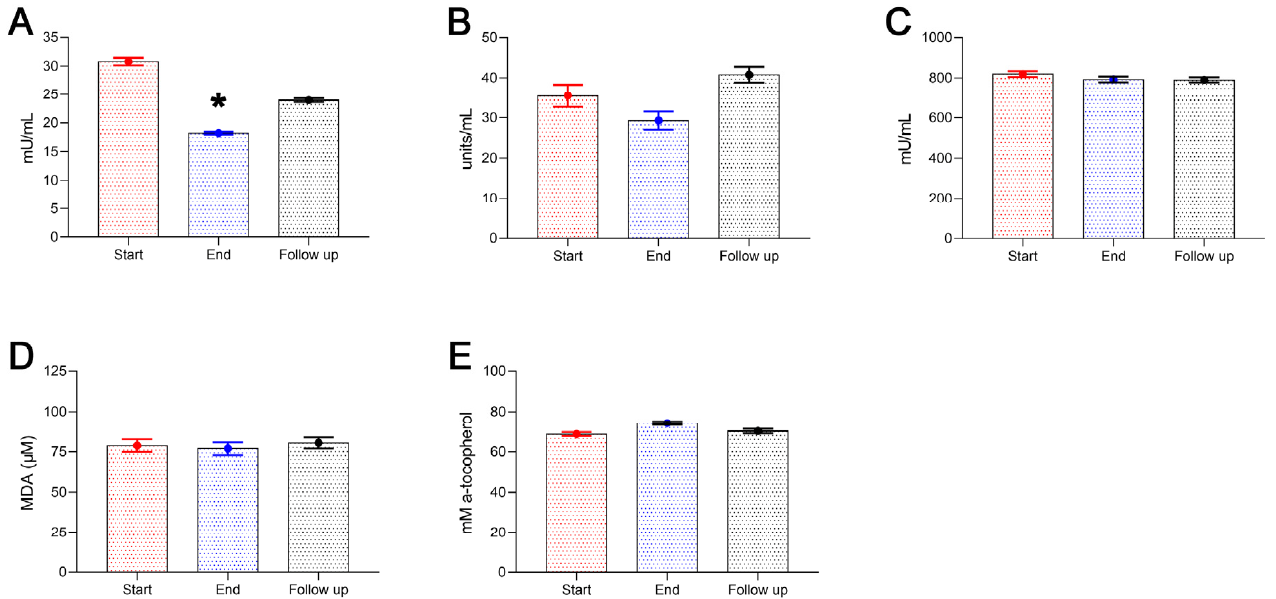
Figure 4. Antioxidant enzyme activity and markers of oxidative stress of the subjects during the study. Plasma levels of oxLDL significantly decreased following Antiox-Plus supplementation ( p < 0.05) ( A ). oxLDL increased at follow-up, however, it remained lower than the pro-supplementation period. The Antiox-Plus supplement also exerted a non-significant reduction in catalase activity ( B ). Likewise, glutathione was unaffected by the supplement ( C ). The total antioxidant capacity of plasma was slightly increased ( D ), and lipid peroxidation levels remained stable ( E ). Statistically significant difference from Start (Day 0) is shown as * ( p < 0.05).